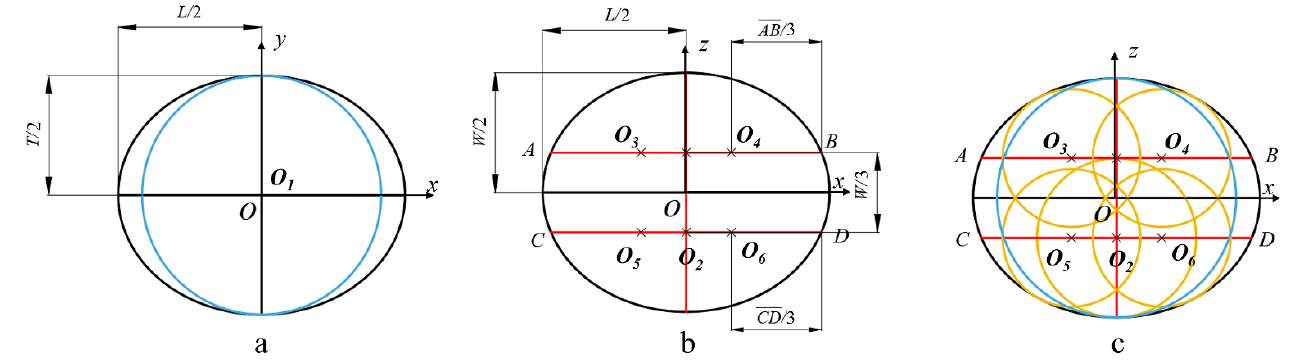
Figure 11. ( a – c ) Filing methods for the multi-sphere model of Jinong 1. length ( L ), and thickness ( T ) of the seed were aligned on the major axis (axis x ), the middle axis (axis z ), and the minor axis (axis y ) of the ellipsoid, respectively. On the xoz plane, first, the width W of the ellipsoid was divided into four segments. Two line segments AB